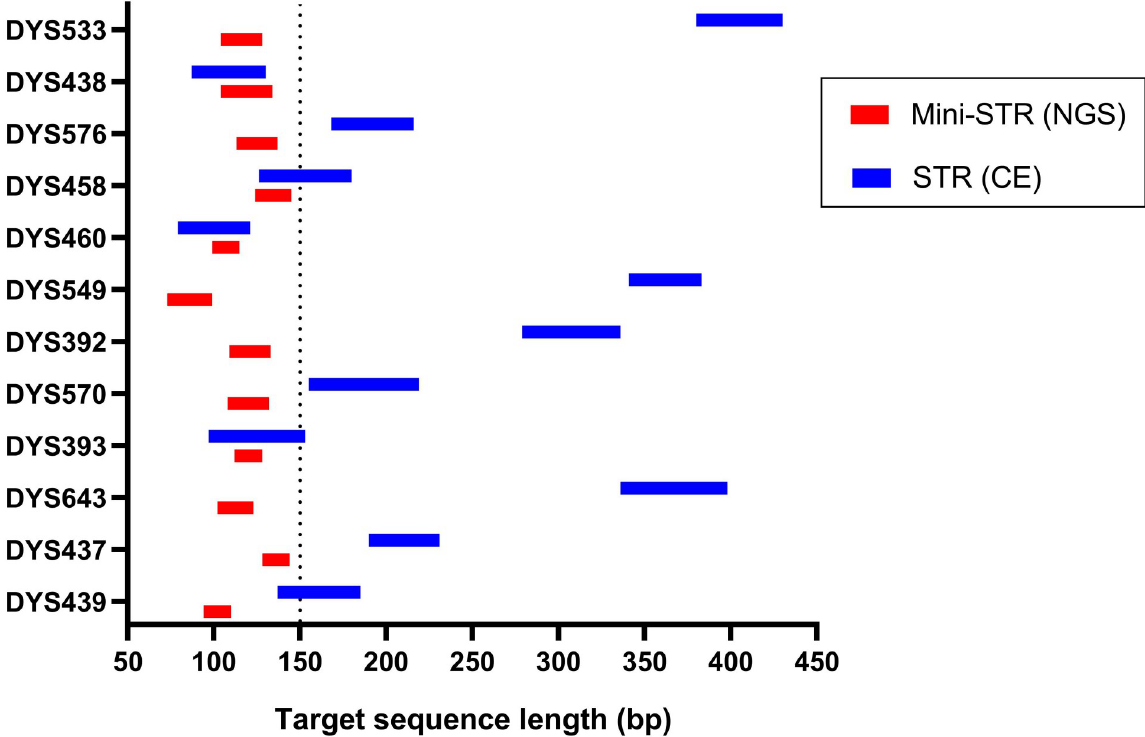
Fig 4. Overview of target sequence length for all STR loci as per NGS and CE. Target sequence indicates the PCR amplicon without barcoding and adapter primers.